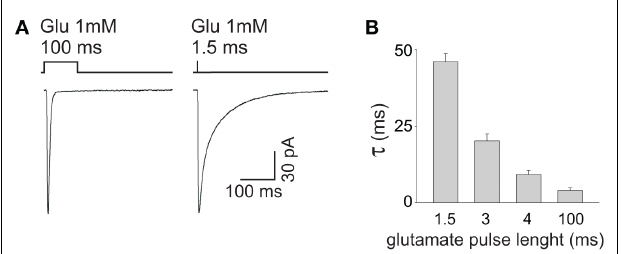
FIGURE 3 |The decay kinetics of currents mediated by GluK2/K5 kainate receptors strictly depends on the length of glutamate pulse. (A) Representative traces of GluK2/K5 currents elicited by long (100ms) and brief (1.5ms) pulses of glutamate 1mM. Please note that the current elicited by brief glutamate pulses (right panel) deactivates markedly slower that that obtained at long glutamate exposures (left panel). (B) Dependence of GluK2/K5 current deactivation kinetics upon glutamate pulse length. Modified from Barberis et al. (2008) with